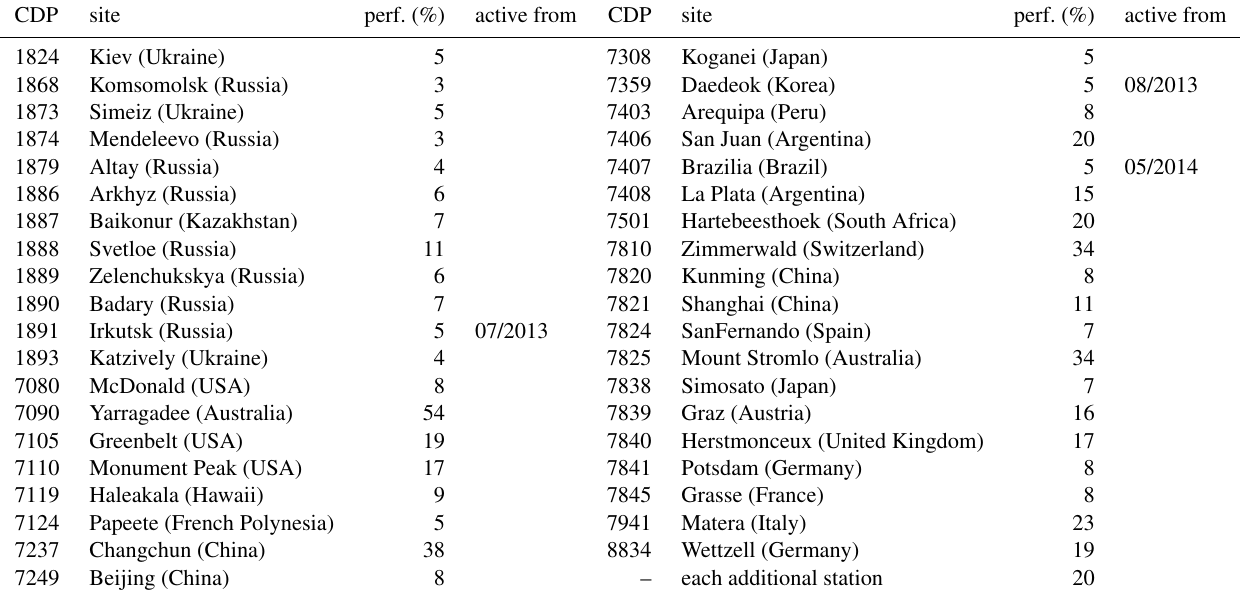
Table 2. Simulated pass performances for the stations in the existing network (assumed to include AGGO La Plata) and the additional sites. CDP site perf. (%) active from CDP site perf. (%) active from 1824 5 7308